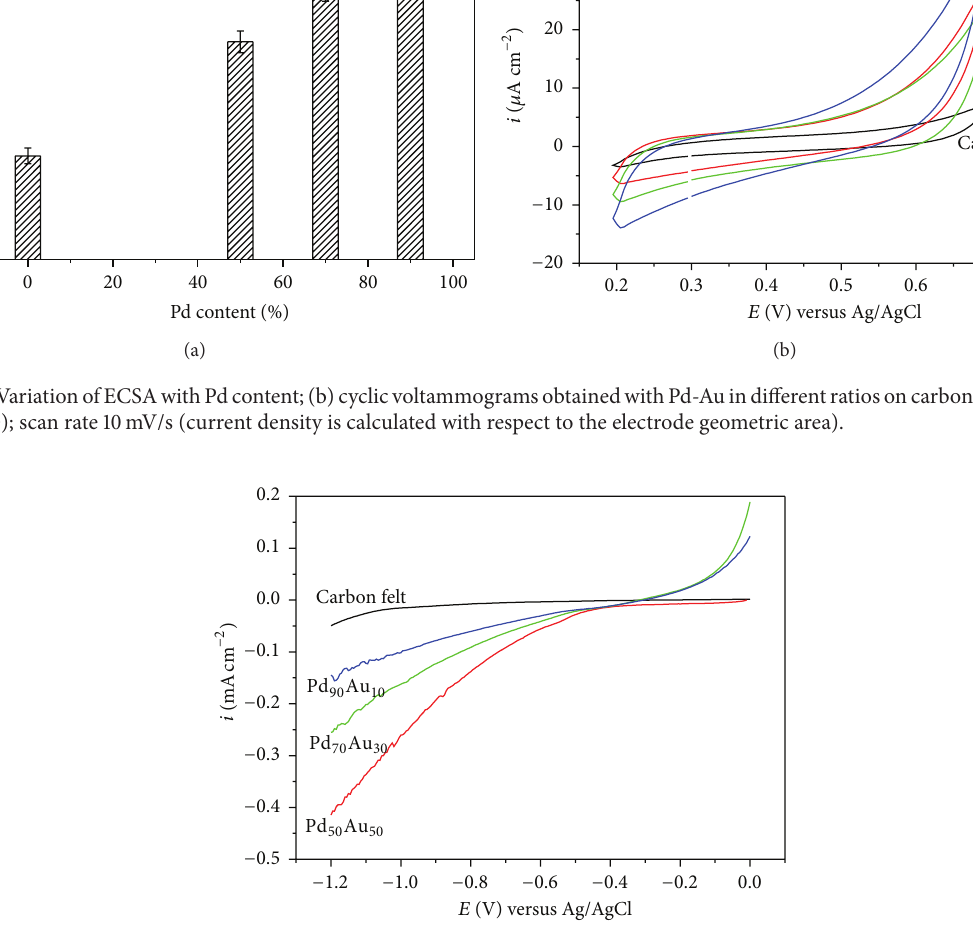
Figure 4: Linear voltammograms obtained with Pd-Au electrodeposits on carbon felt in neutral phosphate buffer (the current density is normalized against ECSA).